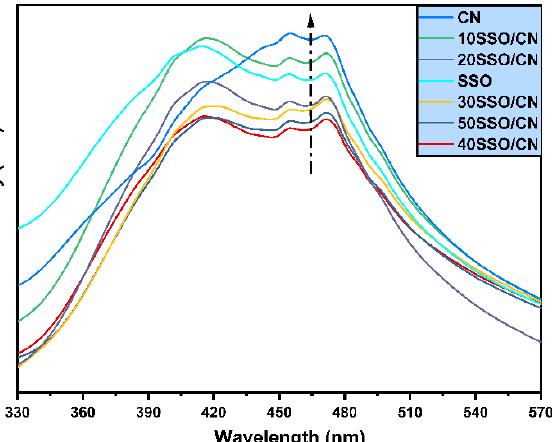
Figure 7. PL emission patterns of CN, SSO, 10SSO/CN, 20SSO/CN, 30SSO/CN, 40SSO/CN, and 50SSO/CN.